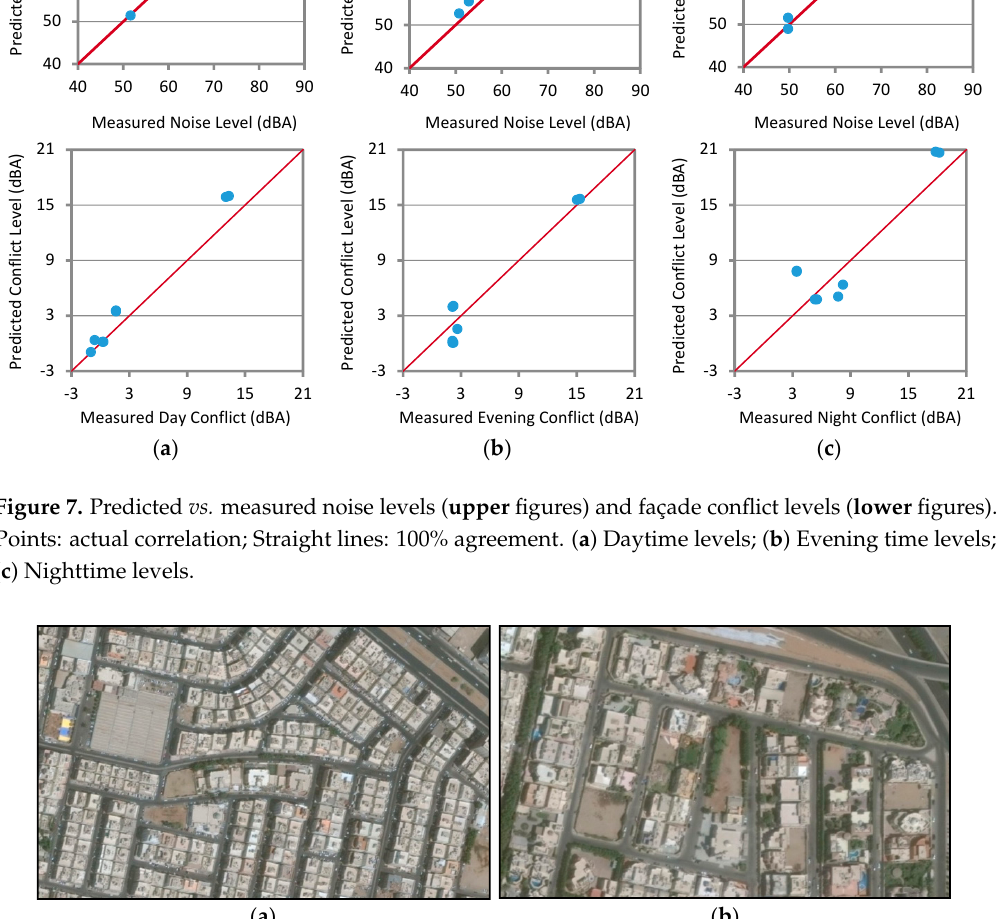
Figure 8. Aerial photos of the two types of houses in Al-Fayha district: ( a ) multistory houses; ( b ) Detached houses (Villas).